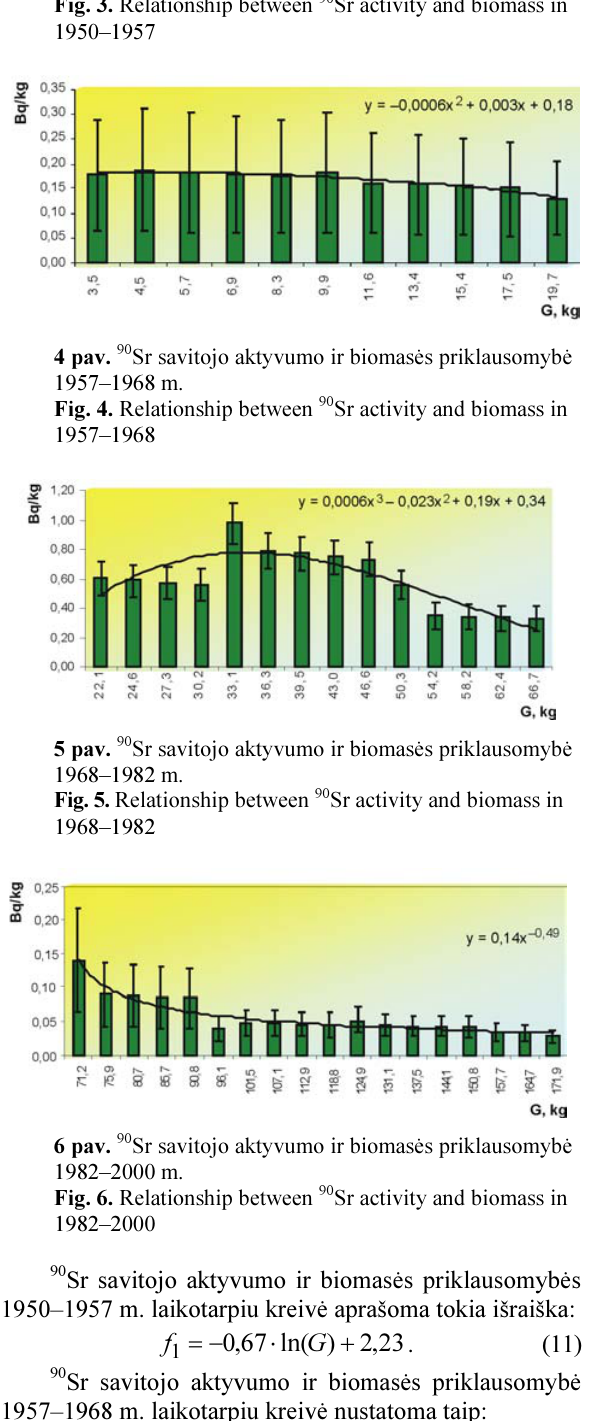
Fig. 3. Relationship between